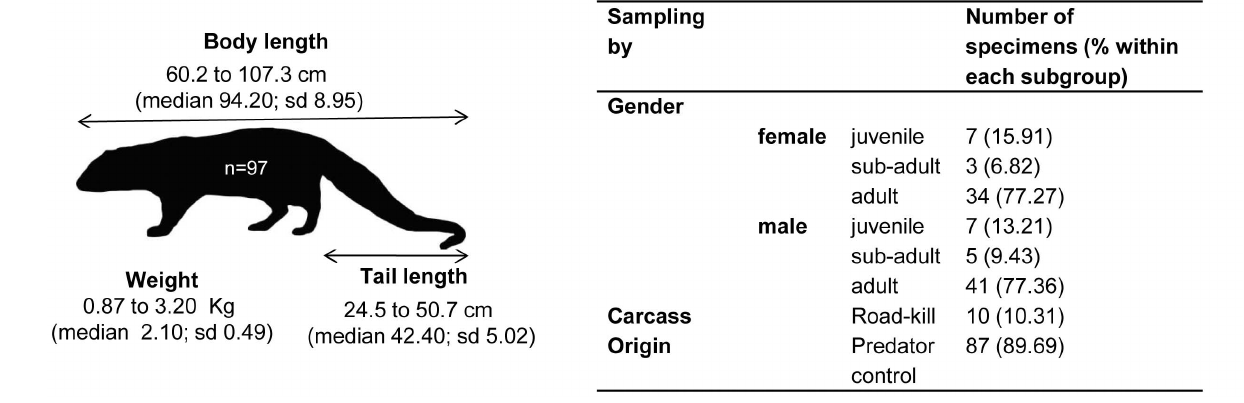
Figure 6. Biometric measurements and collection method of mongoose subpopulation (n=97) used in modeling analysis.